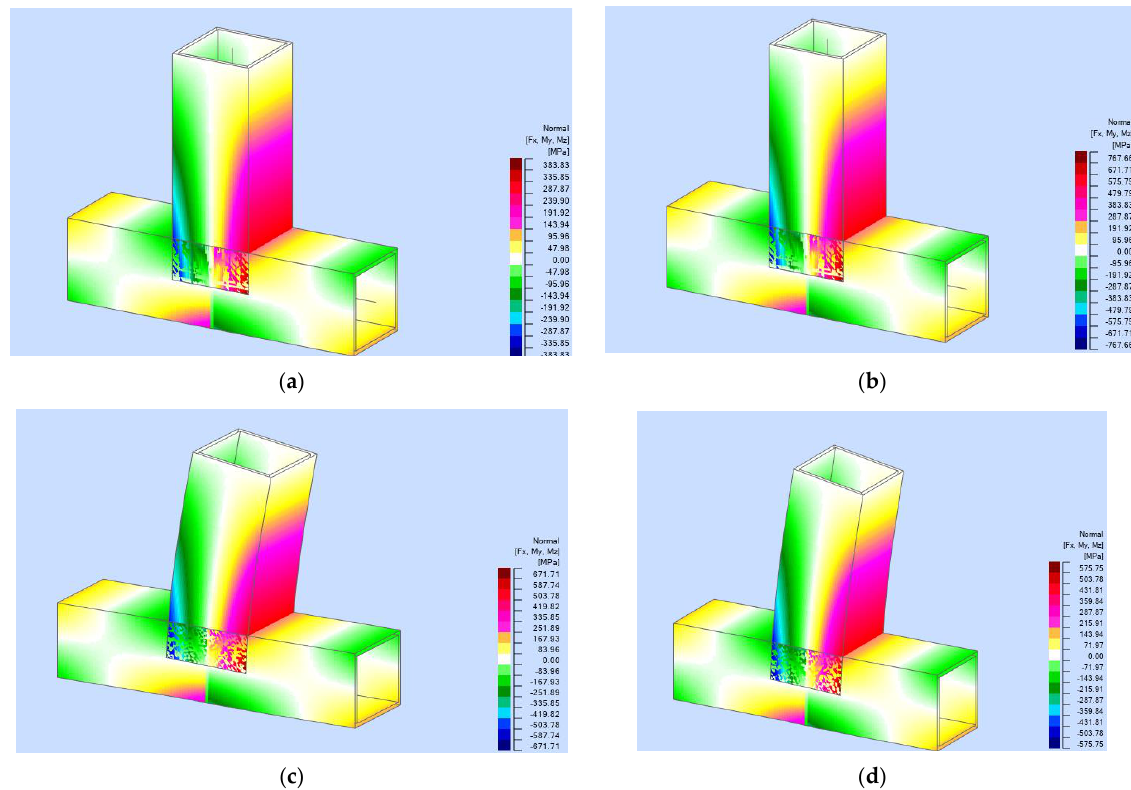
Figure 20. Failure modes of beam-columns obtained from the RSA. ( a ) BCG − H; ( b ) BCG − E60P; ( c ) BCG − E70P; ( d ) BCG − E80P.